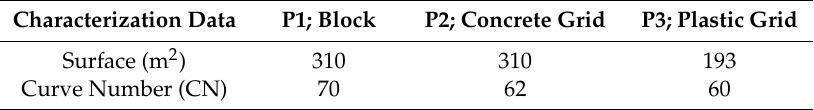
Table 1. Curve Number (CN) and area of the permeable